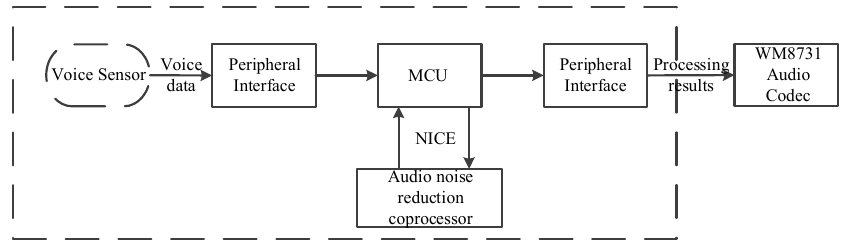
Figure 8. System data flow diagram.